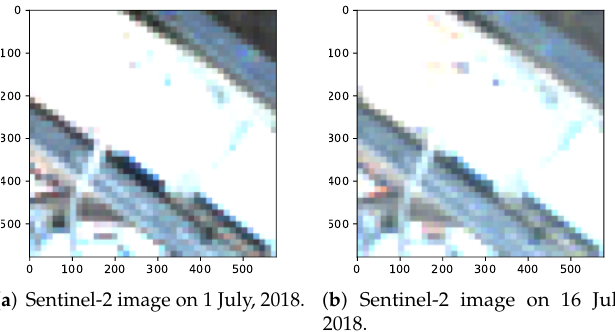
Figure 15. Sentinel-2 images of a true-positive blob of a factory yard in Alberton.